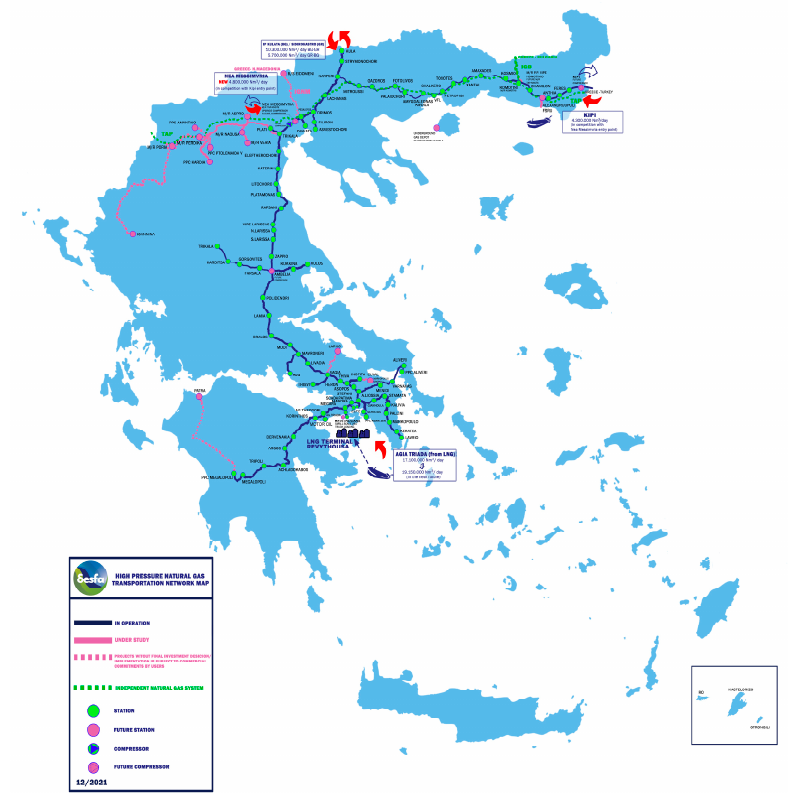
Figure 7. National natural gas transmission system